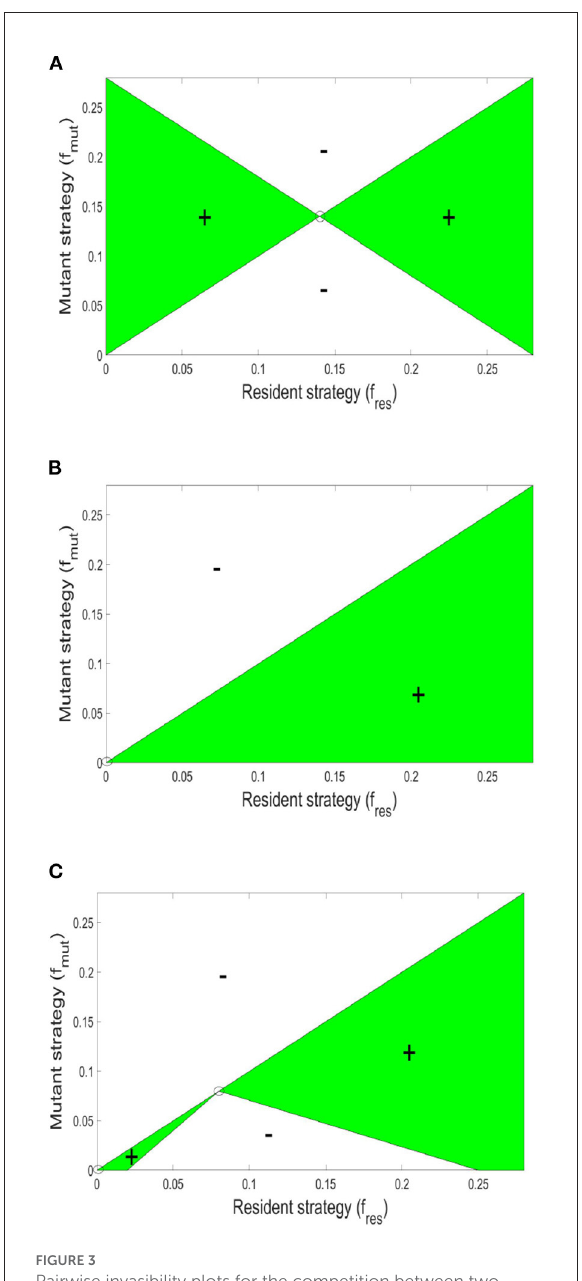
FIGURE3 Pairwise invasibility plots for the competition between two constitutive toxin producing strains under different conditions. The green areas are where a mutant toxin production strategy, f mut , fares better than a resident toxin production strategy, f res . And thus can spread in the population. A resident strategy is said to be evolutionary stable if it can not be invaded by any mutant. (A) High toxin lethality/high initial nutrient concentration [ N ( t = 0) = 10 4 mg l − 1 , K T = 15 × 10 − 4 l mg toxin − 1 h − 1 ]: here, producing toxin can be advantageous up to a certain extent. When the two strains are producing toxin at an optimal investment rate f ∗ , lying here at the center of the graph, no mutant can fare better. (B) At low toxin lethality/ low initial nutrient concentration parameter region [ N ( t = 0) = 10 3 mg l − 1 K T = 1.5 × 10 − 4 l mg toxin − 1 h − 1 : in such conditions producing